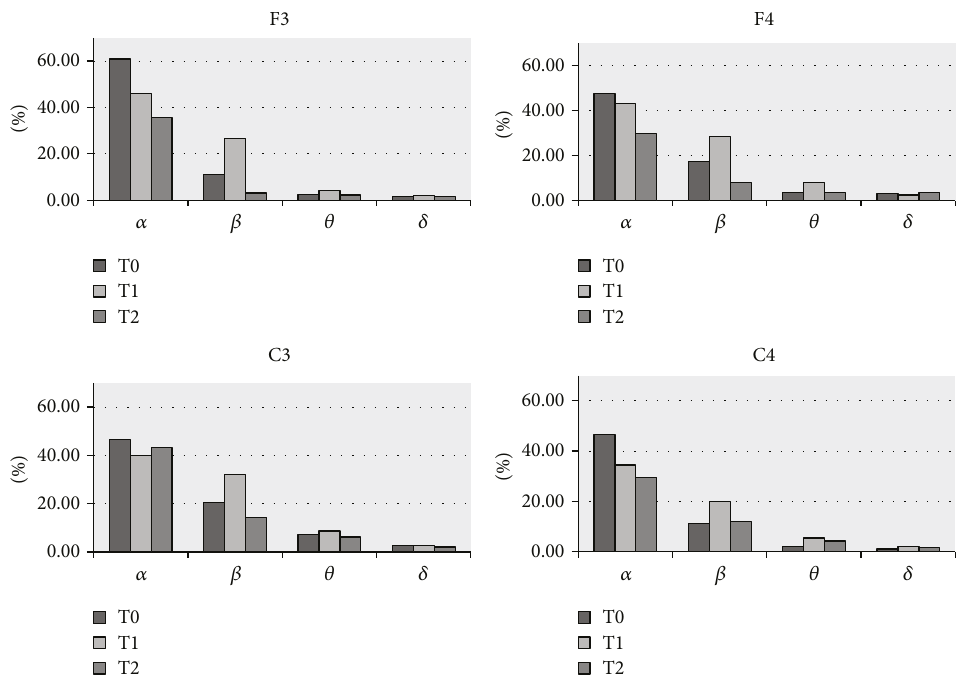
Figure 3: Delta, theta, alpha, and beta relative powers (%) presham and postsham rTMS at T0, T1, and T2 in patient number 5. The beta power at four electrode sites increased after sham rTMS treatment (T1) and decreased within one week (T2).